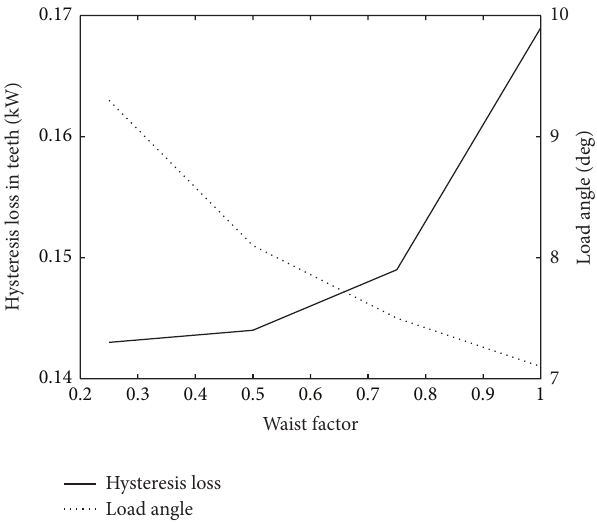
Figure 3: The hysteresis loss in the stator teeth and the load angle as a function of the waist factor.